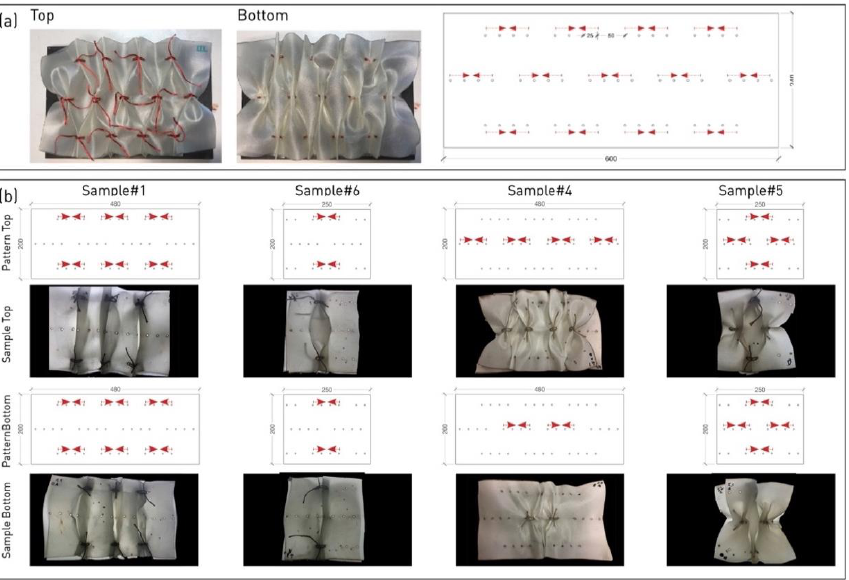
Figure 3. Samples of two experimental campaigns. ( a ) First campaign: typical sample top (left), and bottom view (middle), pleating pattern for both layers (right). ( b ) Second campaign: four tested samples, views and pleating patterns of top and bottom layers.